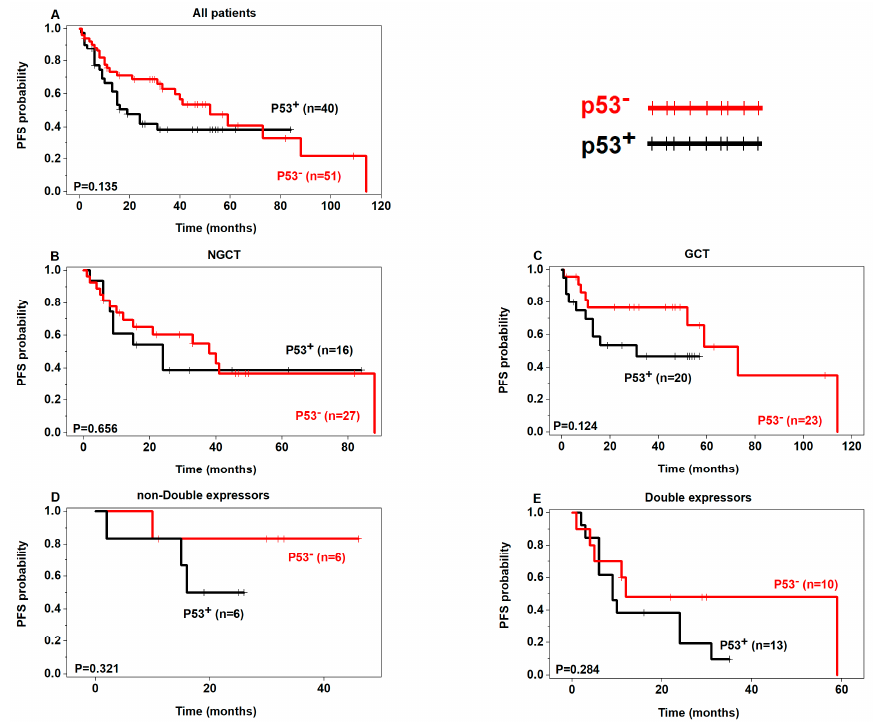
Figure 3. Prognostic analysis of p53 expression in DLBCL (PFS) (p53+ in black, p53– in red).